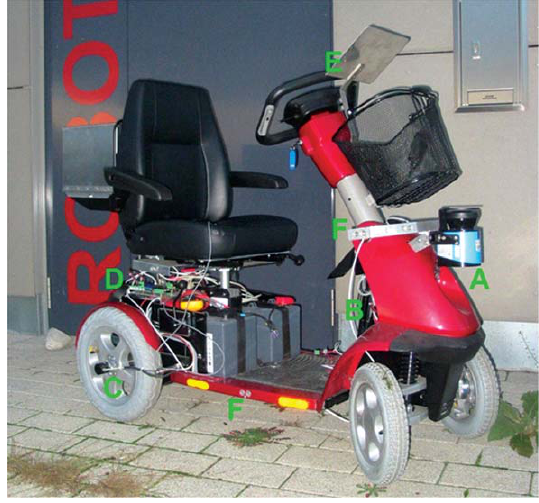
Fig. 1. The mobility scooter equipped with all electronics and sen- sors A) Laser Range Finder, B) steering motor, C) incremental sensor, D) electronics, E) mounting device of the navigation system, F) ultrasonic